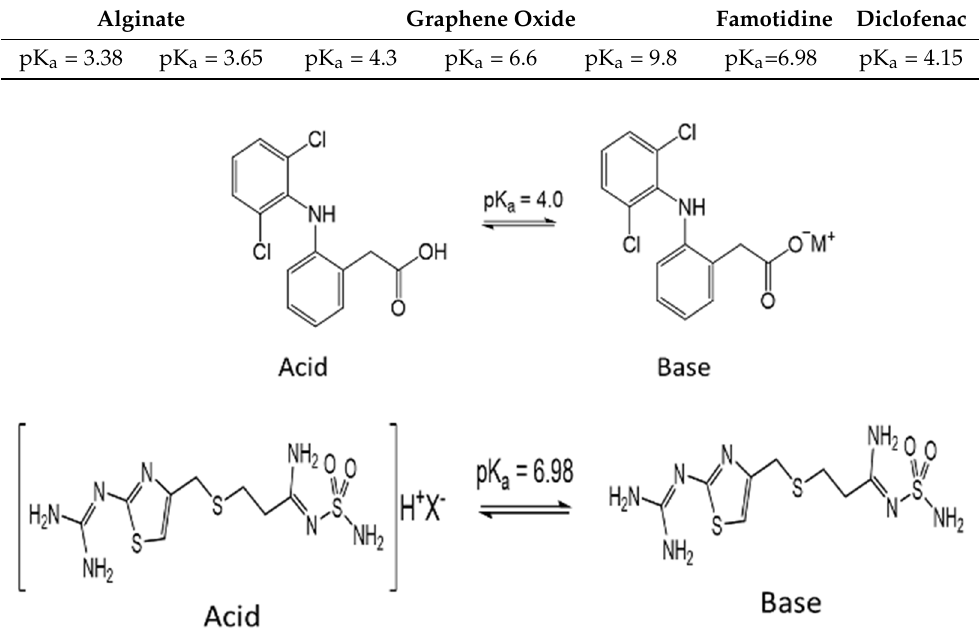
Table A1. Reported pKa values from the literature.